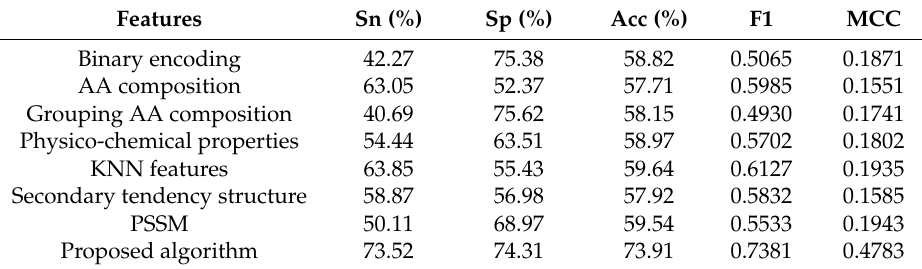
Table 2. Performances of different features in M. musculus .